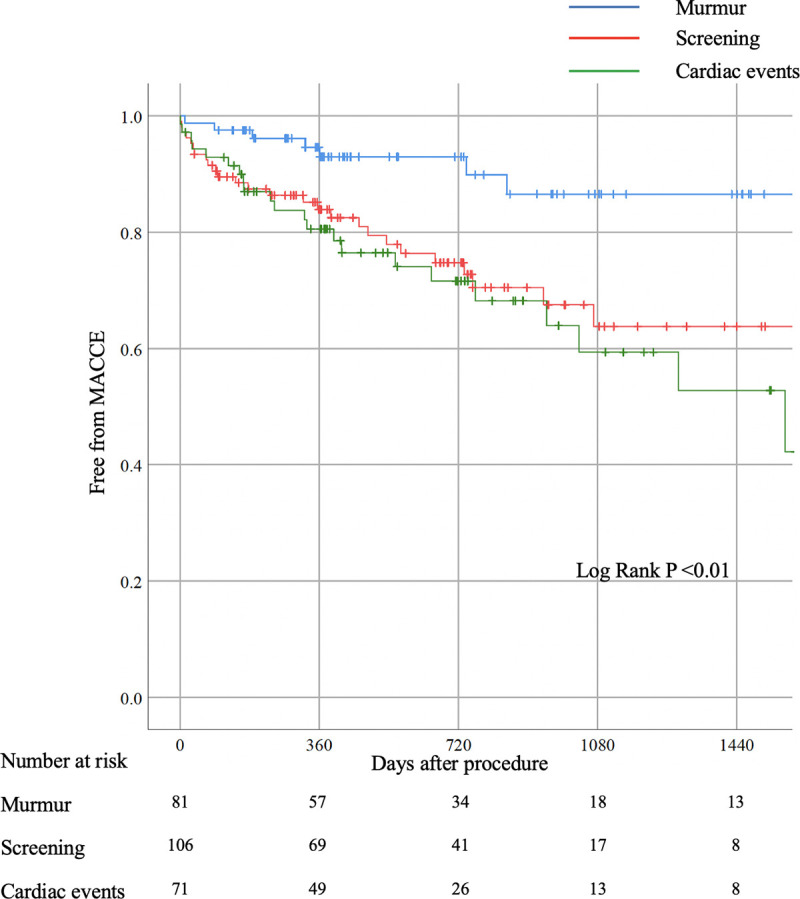
Kaplan-Meyer survival curve analysis among three groups.Each group defined according to the primary reasons like below; Murmur group: Equal the murmur group. Screening group: Composite of screening for cardiac symptom and non-cardiac pre-operations. Cardiac events group: hospitalization for some cardiovascular events.